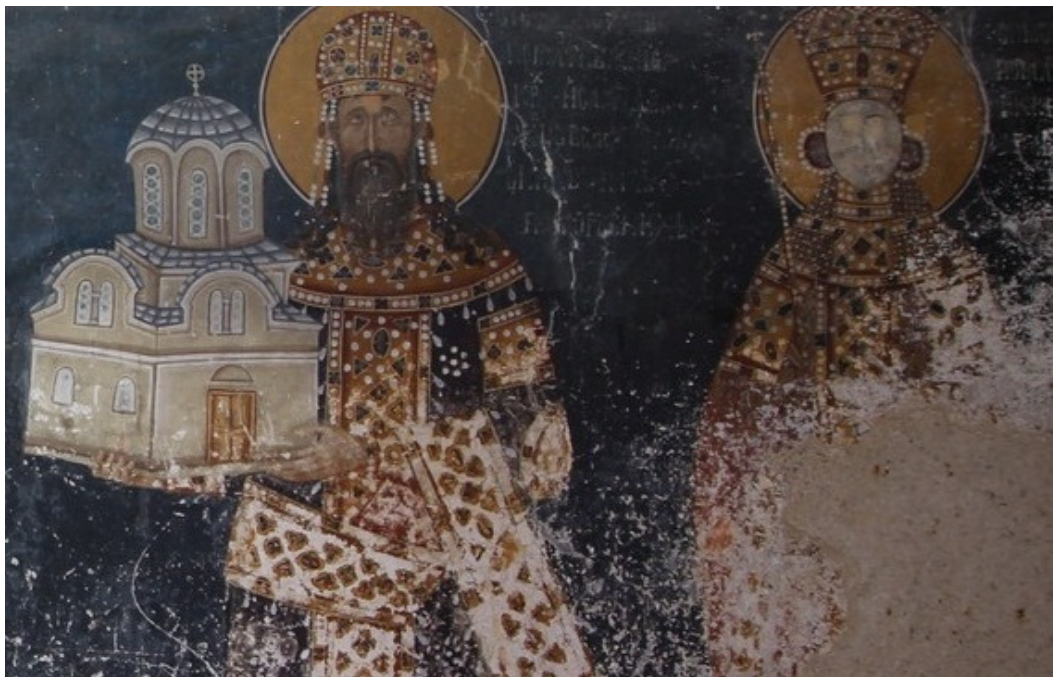
Figure 4. King Milutin carrying church and Queen Symonis, fresco, 1318–1319 King’s church, Sts. Joachim and Anne, Studenica Monastery, Courtesy BLAGO Fund,